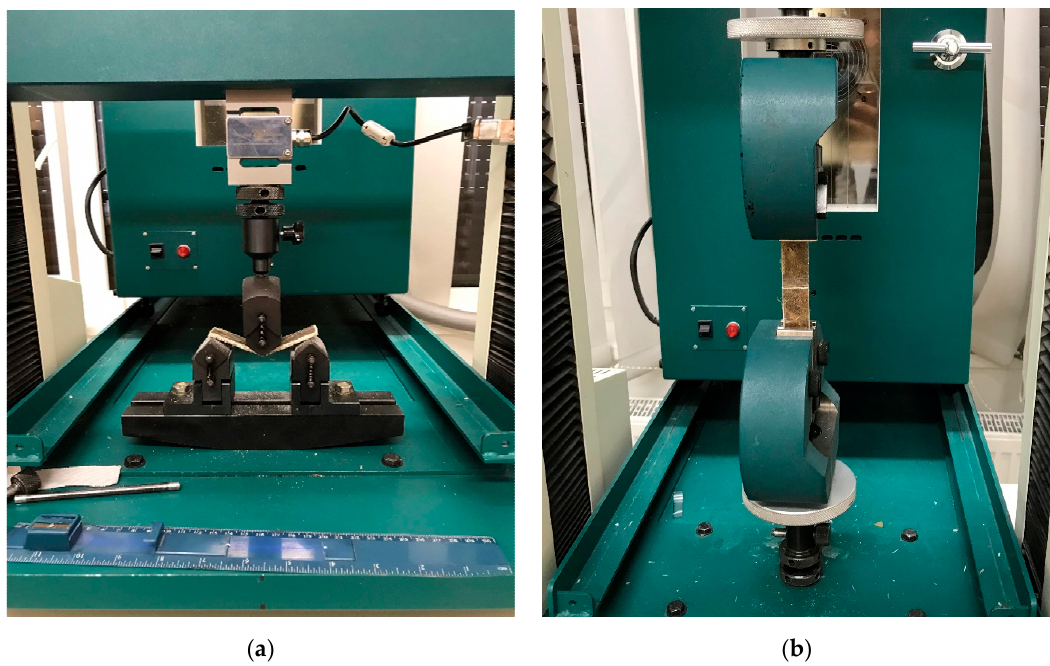
Figure 4. Three-point bending test for flexural properties on Tinius Olsen ( a ); interlaminar shear strength test on Tinus Olsen ( b ).